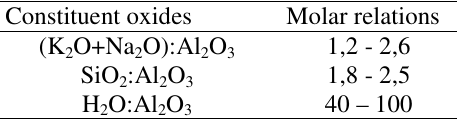
Table 1. Molar relations of reagents 3